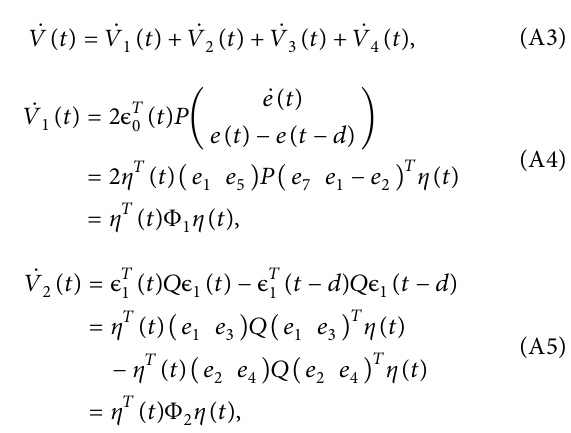
Table 1: The maximum upper bounds of d μ in Example 2.